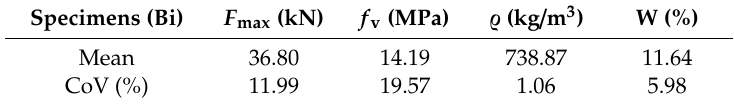
Table 3. Shear tests results obtained for the bond line evaluation using surface-bonding specimens (Bi).